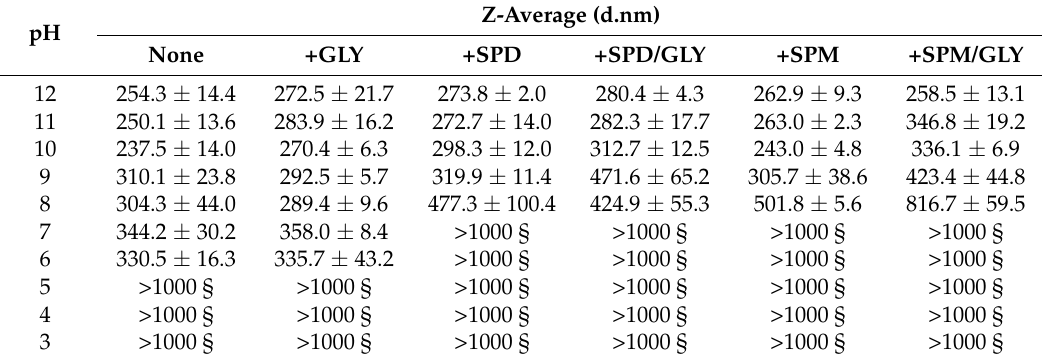
Table 2. Effect of 5 mM polyamines (PAs) on Z-average of the nanoparticles contained in the 25 ◦ C-treated BVPC FFS measured at different pH values both in the absence and presence of 42 mM GLY